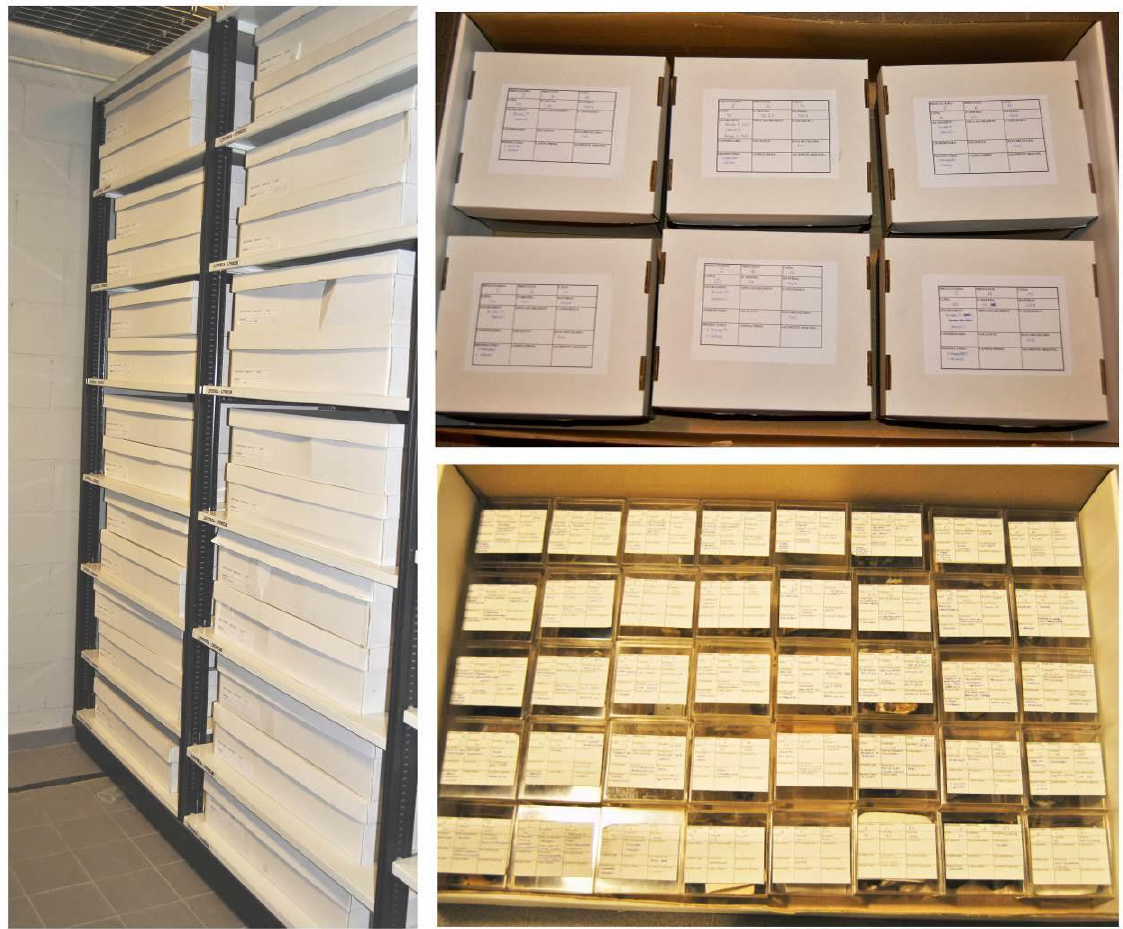
Figure 1. Lithotheque organisation at the